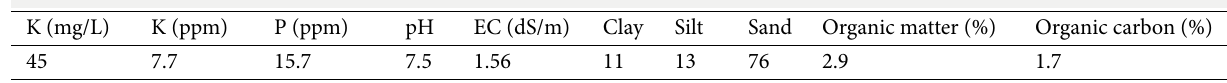
Table 1 Physical and chemical analysis of experimental